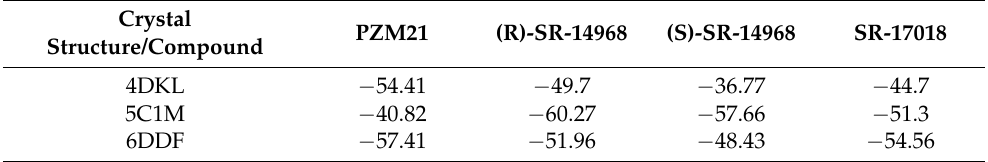
Table 2. Binding free energies (reported in kcal/mol) of PZM-21 and SR compounds computed on the basis of the ligand-protein complexes obtained in docking. Crystal